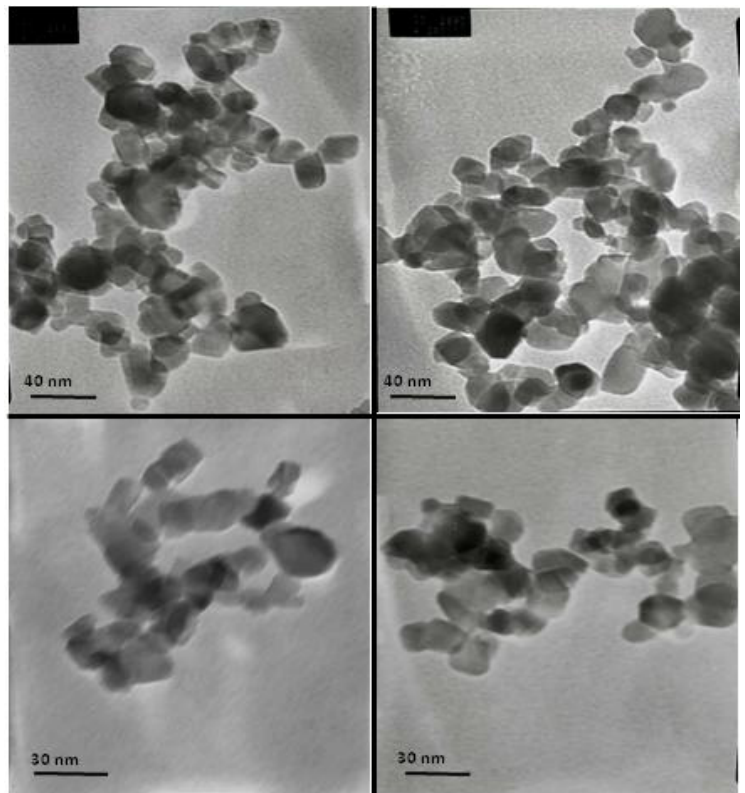
Figure 2. The measured Brunauer-Emmett-Teller (BET) specific surface area of 43 m 2 g −1 of TiO is in 2 agreement with the analyzed crystal size and shape. The material used in the present study was found to be homogenous through all the samples used. Figure 1. TEM images of TiO Aeroxide ® TiO P25. 2 2